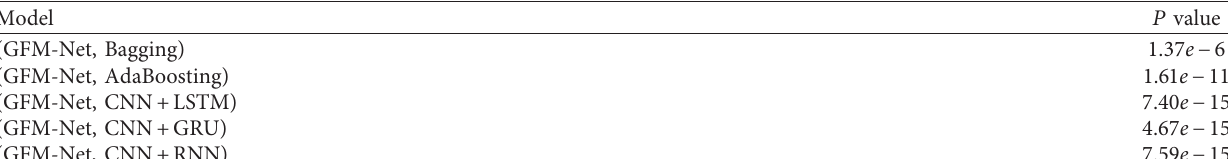
Table 3: The difference between GFM-Net results and other model results is significant P value.